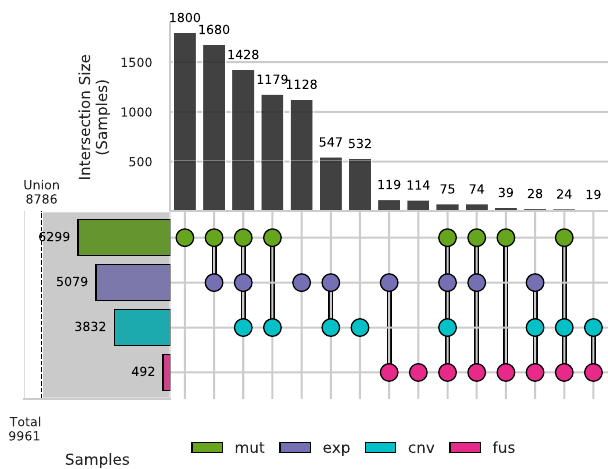
Fig. 8 Proportion of samples ( n = 9,961) with therapeutic matches derived from each combination of variant types. Upset plot of the number of samples with therapeutic matches from annotation of a given variant type. Sample variants are divided into four types: copy number variants (cnv); single nucleotide variants and indels (mut); gene fusions (fus); and gene expression (exp) variants. The left-hand bar plots are the total number of samples which have 1 or more therapeutic conclusions matched to the listed variant type. The union of all matches is given by the shaded portion and vertical dashed line. The upper bar plots show the number of samples in each of the intersection groups. These groups are mutually exclusive. Source data are provided as a Source Data fi variants. 1,128 samples (11.3%) had therapeutic matches derived solely from expression data. This highlights an opportunity for greater focus on expression variants and their clinical or biological signi fi cance.